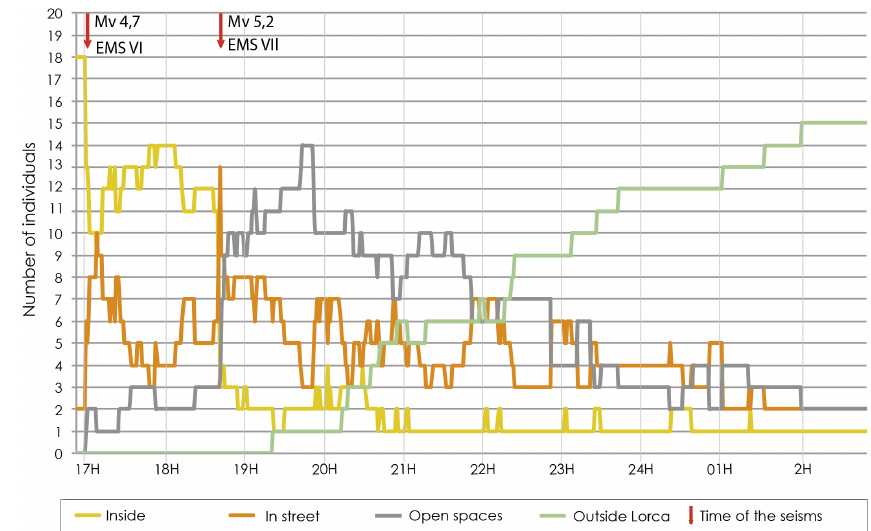
Figure 7. Evolution of the location of individuals in various categories of space during the seismic crisis (inside, in street, open spaces and outside Lorca).